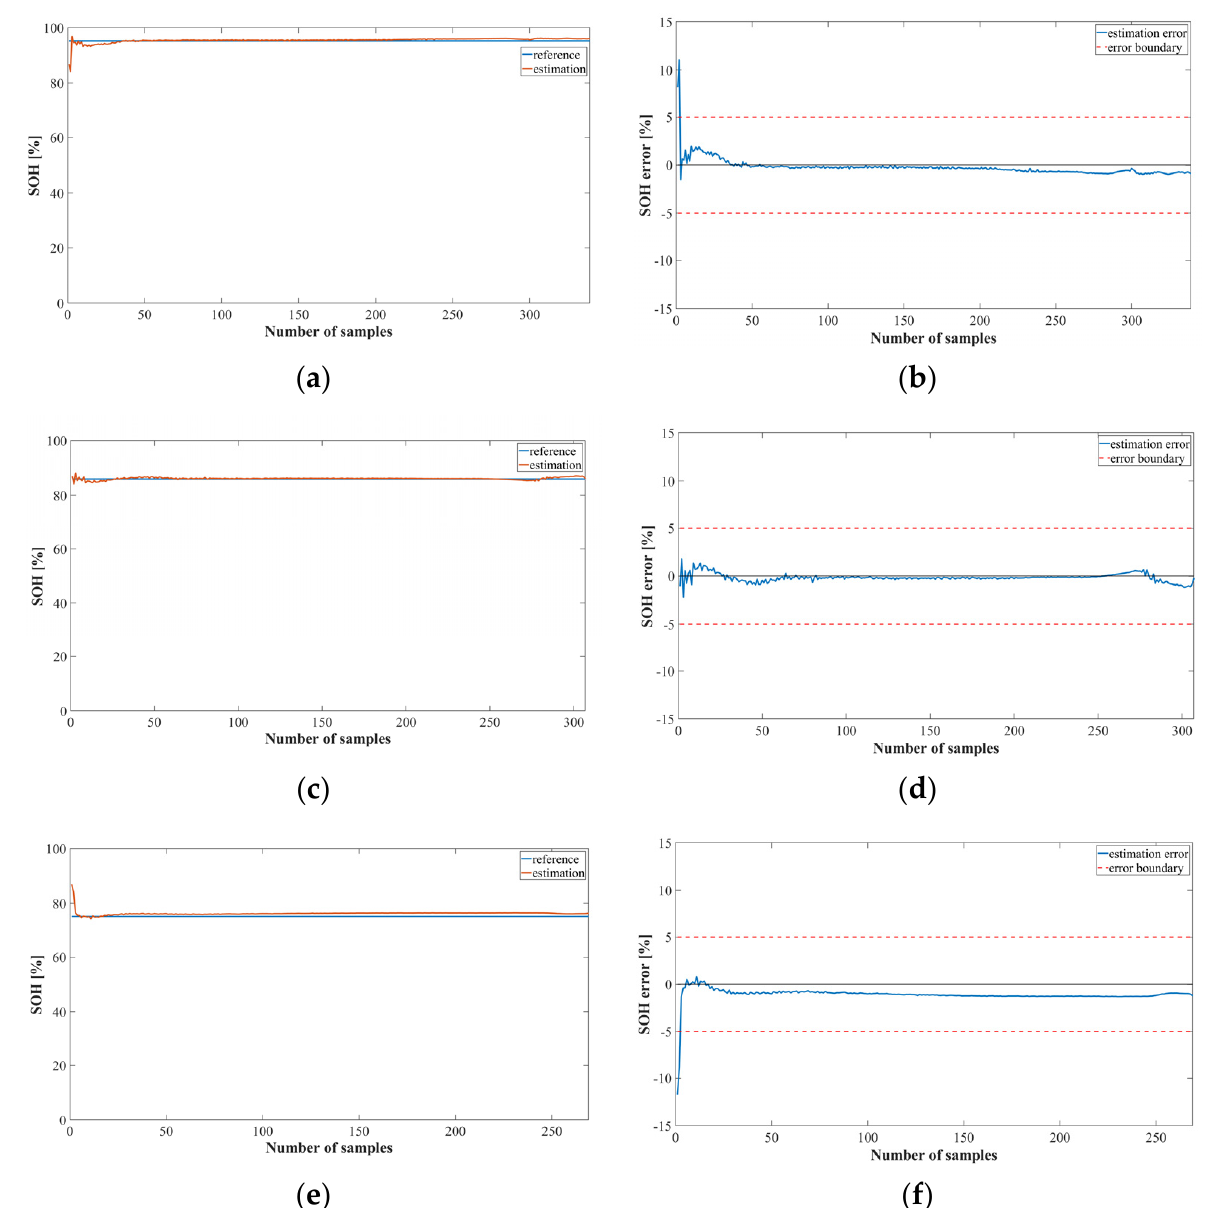
Figure 10. SOH estimation results for Method 2 using the LSTM (NASA dataset): ( a ) SOH estimation result; ( b ) error at cycle 41; ( c ) SOH estimation result; ( d ) error at cycle 78; ( e ) SOH estimation result; ( f ) error at cycle 125.